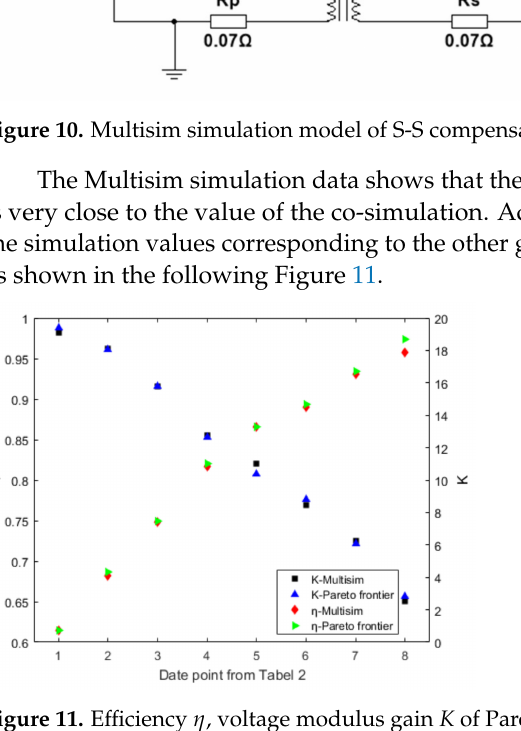
Figure 11. Efficiency η , voltage modulus gain K of Pareto front and